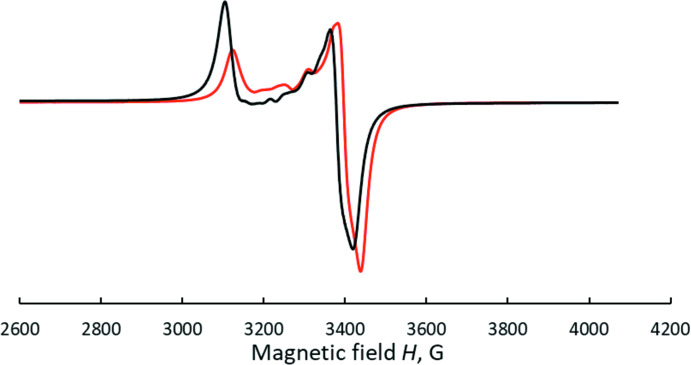
X-band EPR spectra of [CuLCl2]2 (I) in the solid state at 293 (red) and 77 K (black).